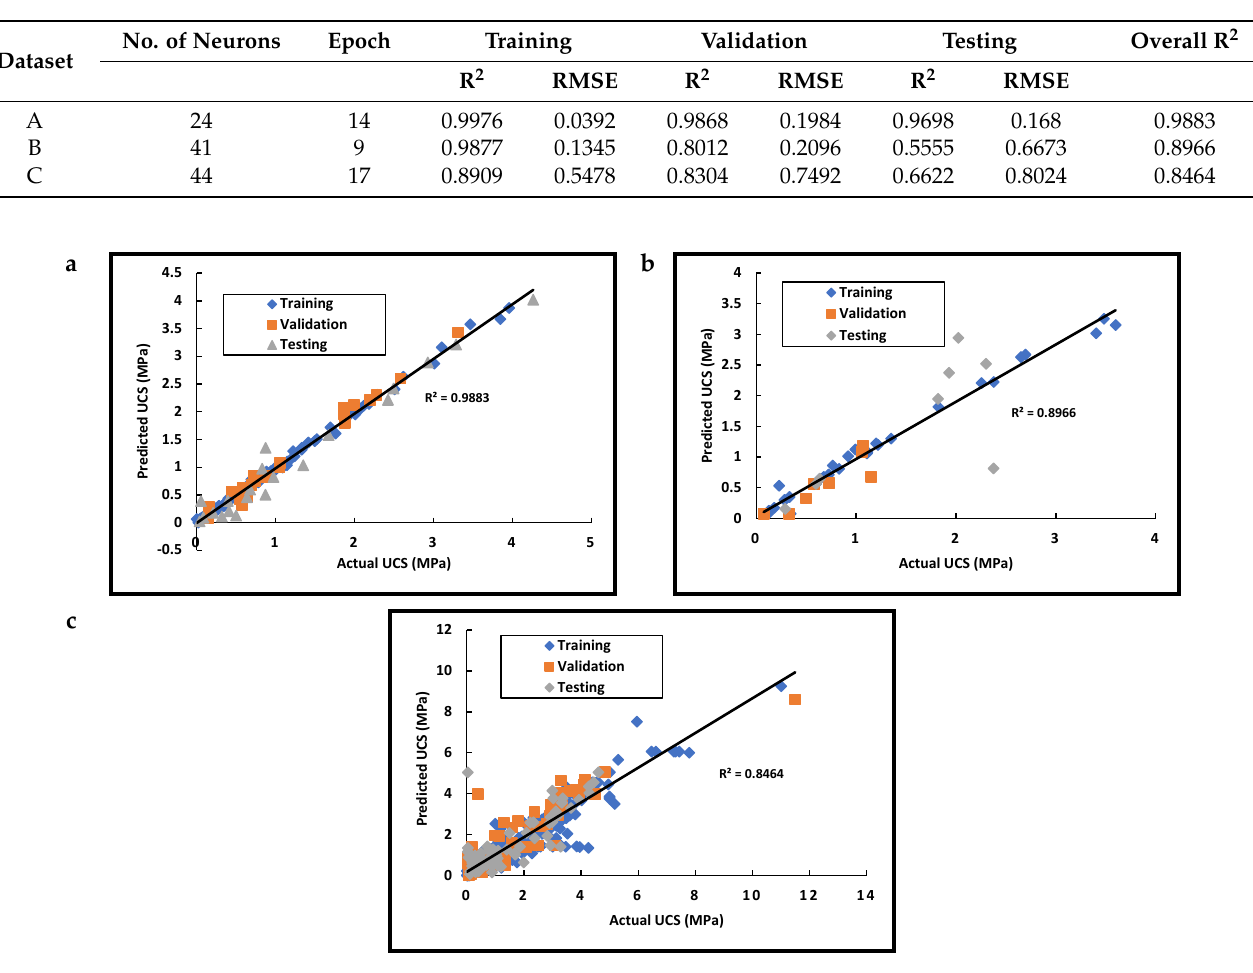
Table 9. ANNs performance comparison for the different datasets at training/validation/testing stages.